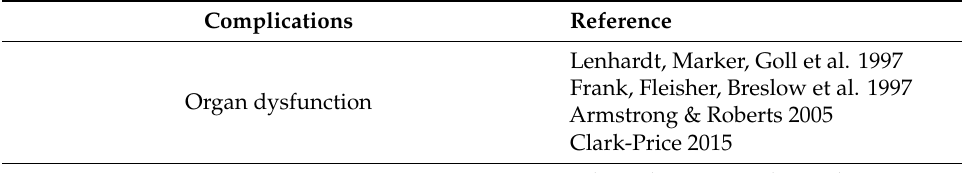
Table 1. Complications associated with perioperative hypothermia